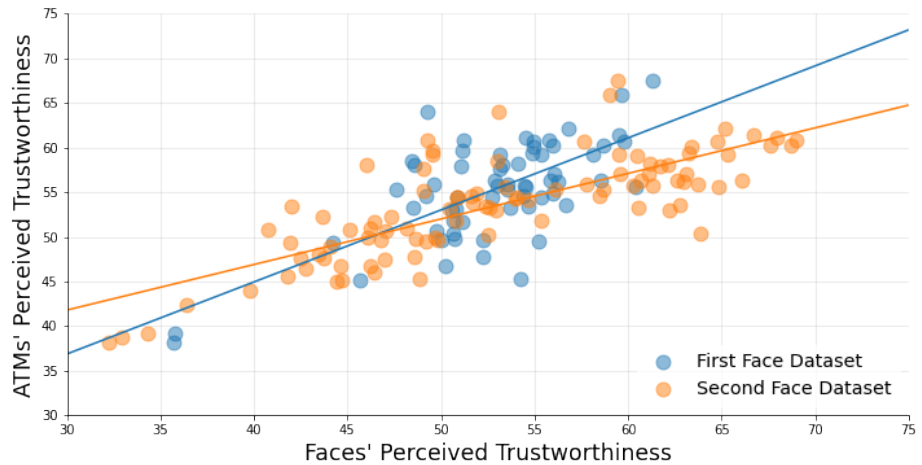
Figure 3. Relation between perceived Trustworthiness of Faces’ and of ATMs’ on which faces are displayed by faces’ ratings dataset (First Face Dataset in blue, Second Face Dataset in